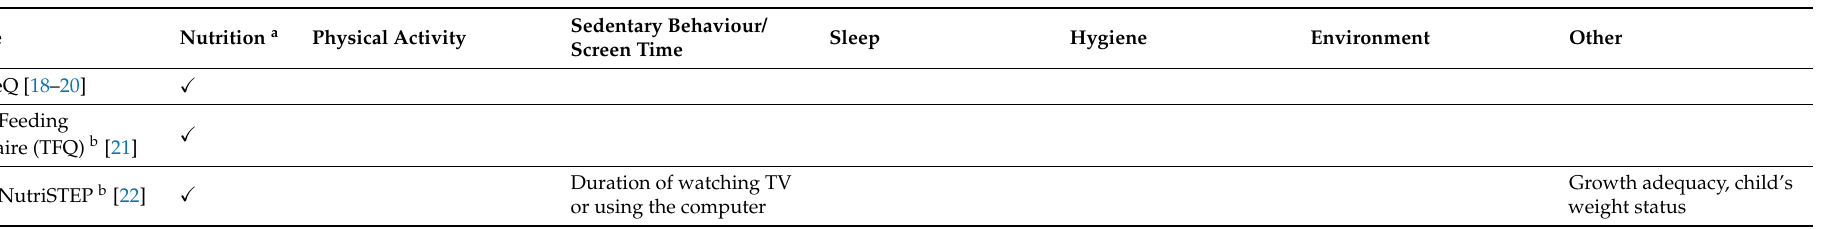
Table 2. Addressed domains and items of lifestyle screening tools for children in the community